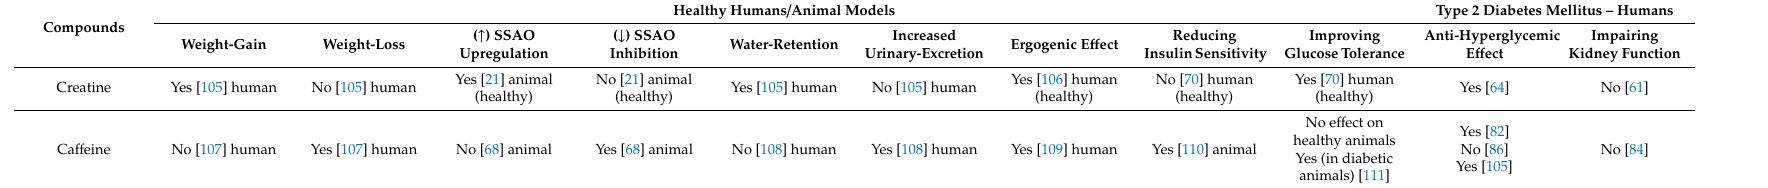
Table 2. Impact of ca ff eine and creatine separate consumption on healthy and diabetic conditions.